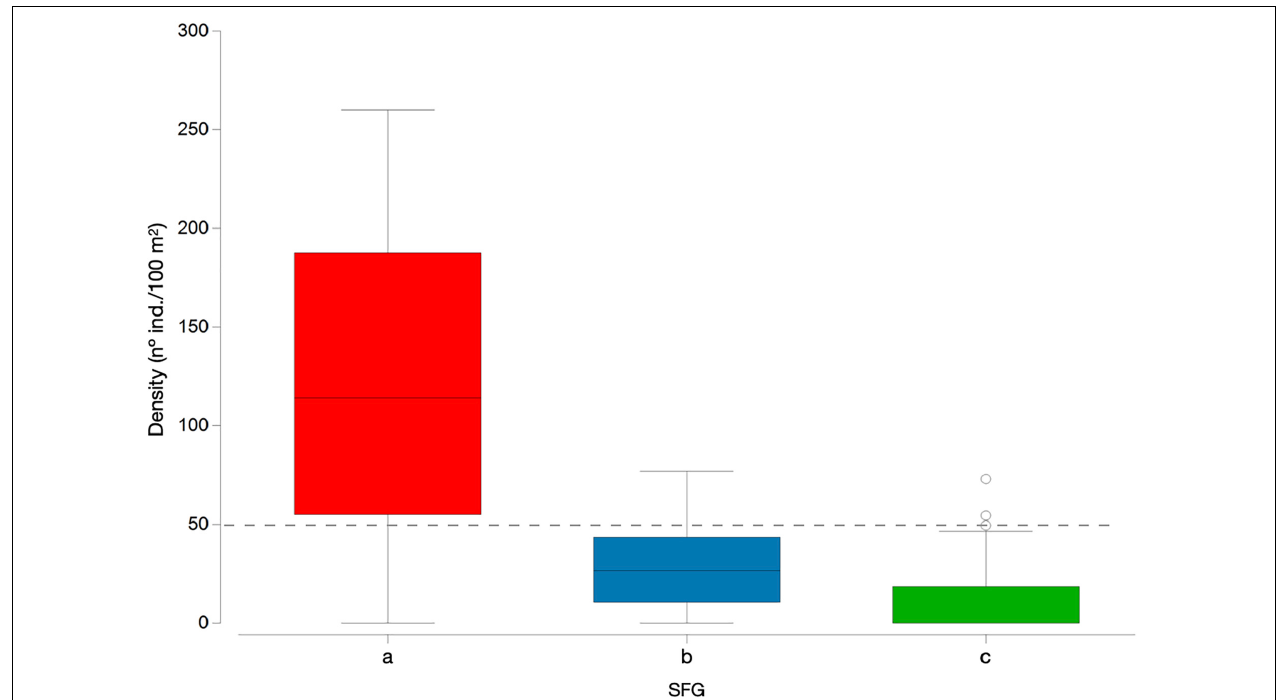
FIGURE 7 | Diadema africanum density (individuals/100 m 2 ) in each of the three identified assemblages (SFG = a, b, c); boxplot with first quartile, median and third quartile, minimum and maximum as whiskers and points as outliers.